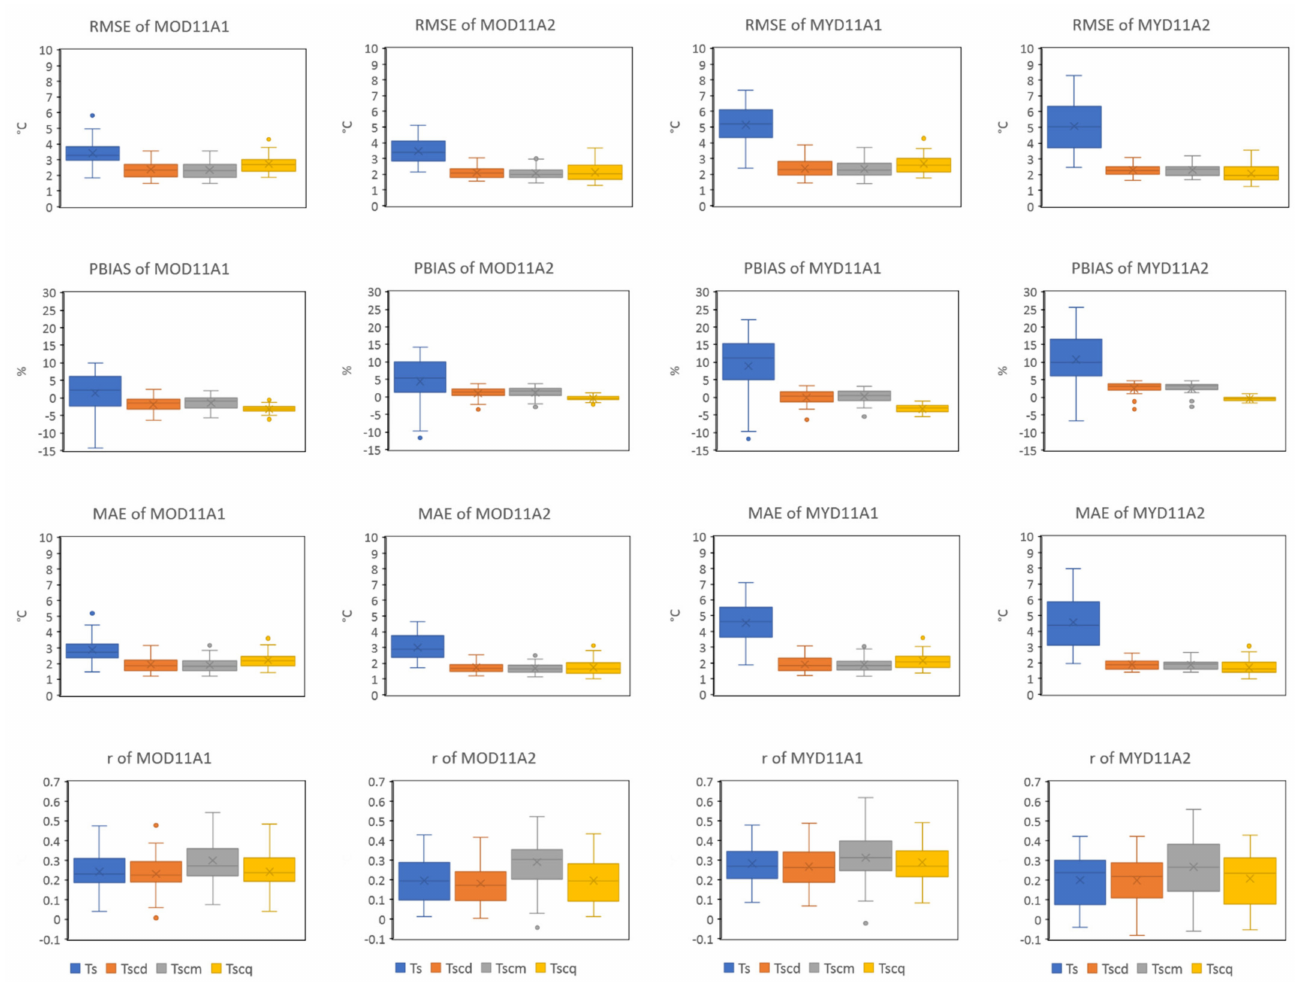
Figure 12. Comparison of evaluation metrics score between T s , T scd , T scm , and T scq against T a . The information obtained from each station (total of 36 stations) and region (total of 5 regions) including (1) the validated range of T s /T s_r and T a /T a_r , (2) constant daily and monthly CF values (LS-MBC), (3) constant daily and monthly mean T s /T s_r and T a /T a_r (LS-MBC), and (4) quantile values for T s /T s_r and T a /T a_r (QM-MBC) can be used for future T a estimation from MODIS T s (MOD11A1, MOD11A2, MYD11A1, and